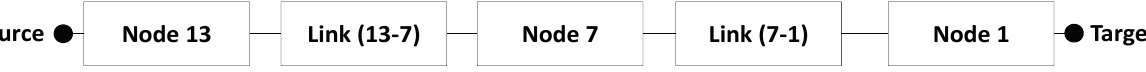
Figure 15. Region Model created when WSN uses the LEACH protocol.